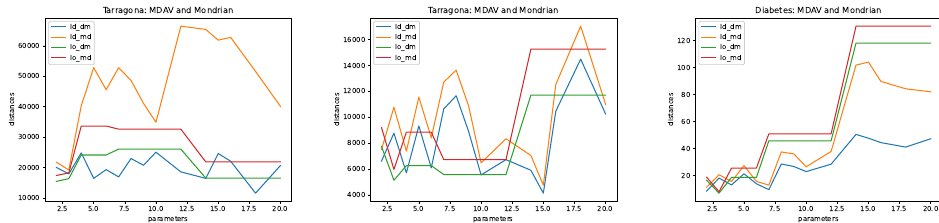
Figure 1. Distance of mean Shapley values (_dm) and mean distance of Shapley values (_md) for MDAV and Mondrian (letters d and o) using linear regression as the machine learning algorithm. Experiments with the Tarragona file were performed considered only the first 11 inputs ( left ), all 12 independent inputs ( middle ), and the Diabetes file ( right